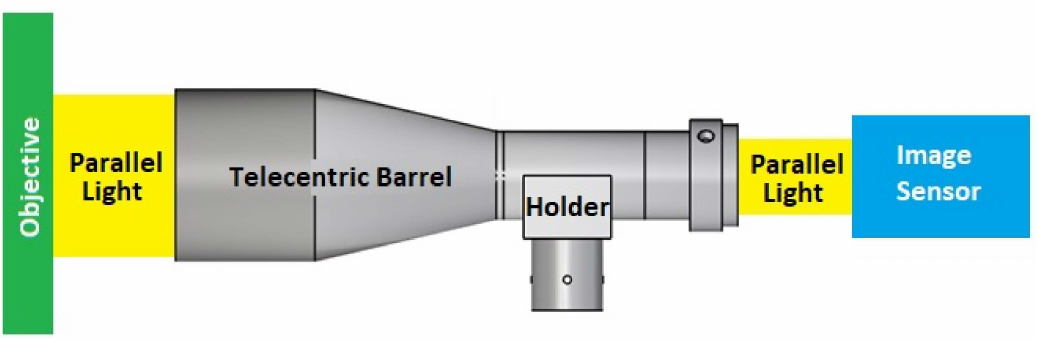
Figure 1. Coaxial bilateral telecentric optical